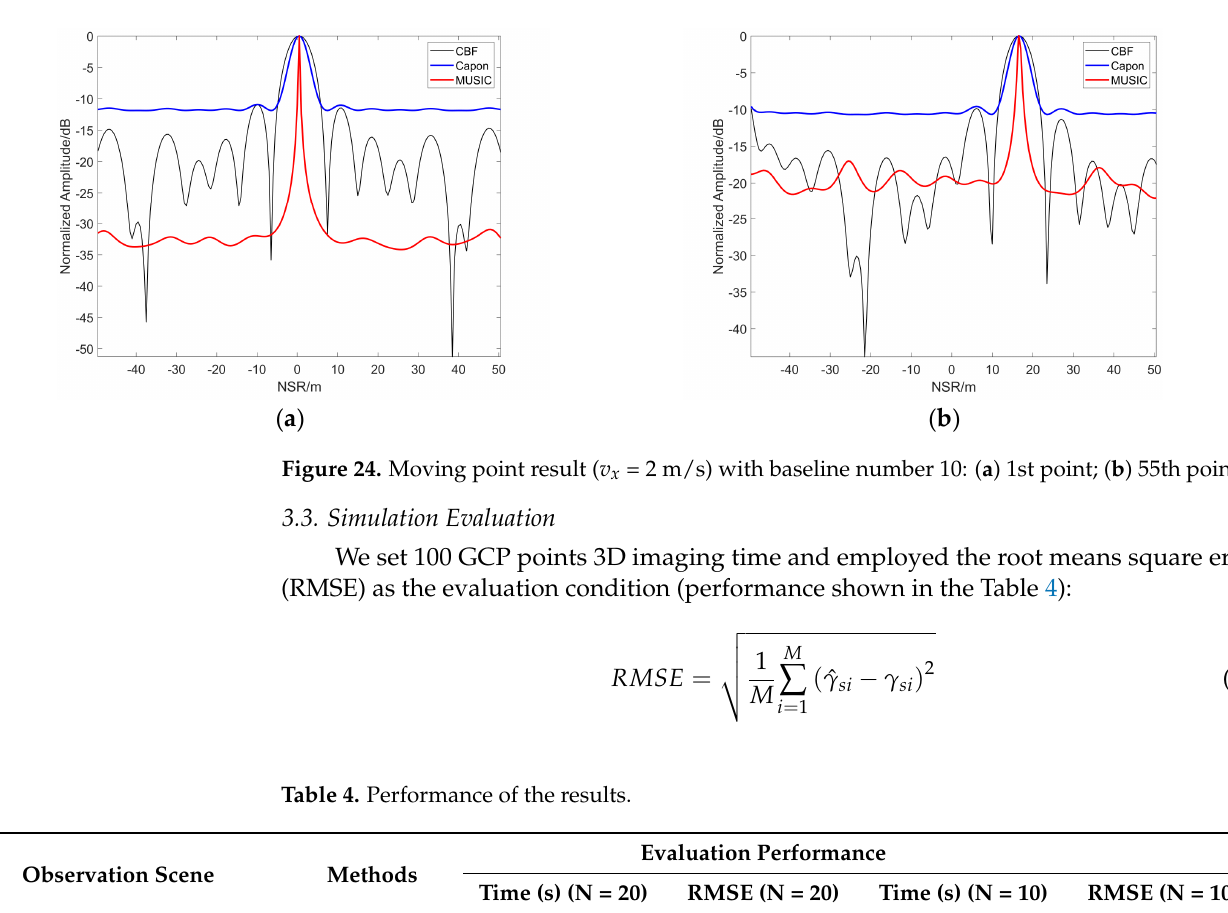
Figure 23. Moving point result ( v x = 2 m/s) with baseline number 20: ( a ) 1st point; ( b ) 55th point.